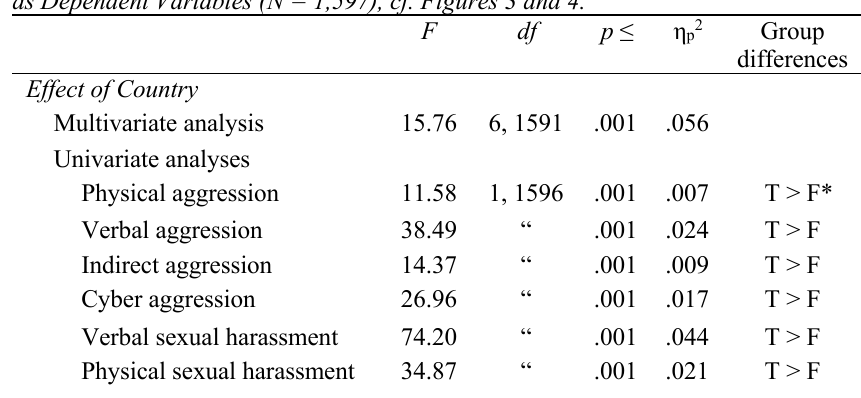
Results from a Multivariate Analysis of Variance (MANOVA) with Country and Sex as Independent Variables, and Perpetration of Aggression and Sexual Harassment as Dependent Variables (N = 1,597), cf. Figures 3 and 4.